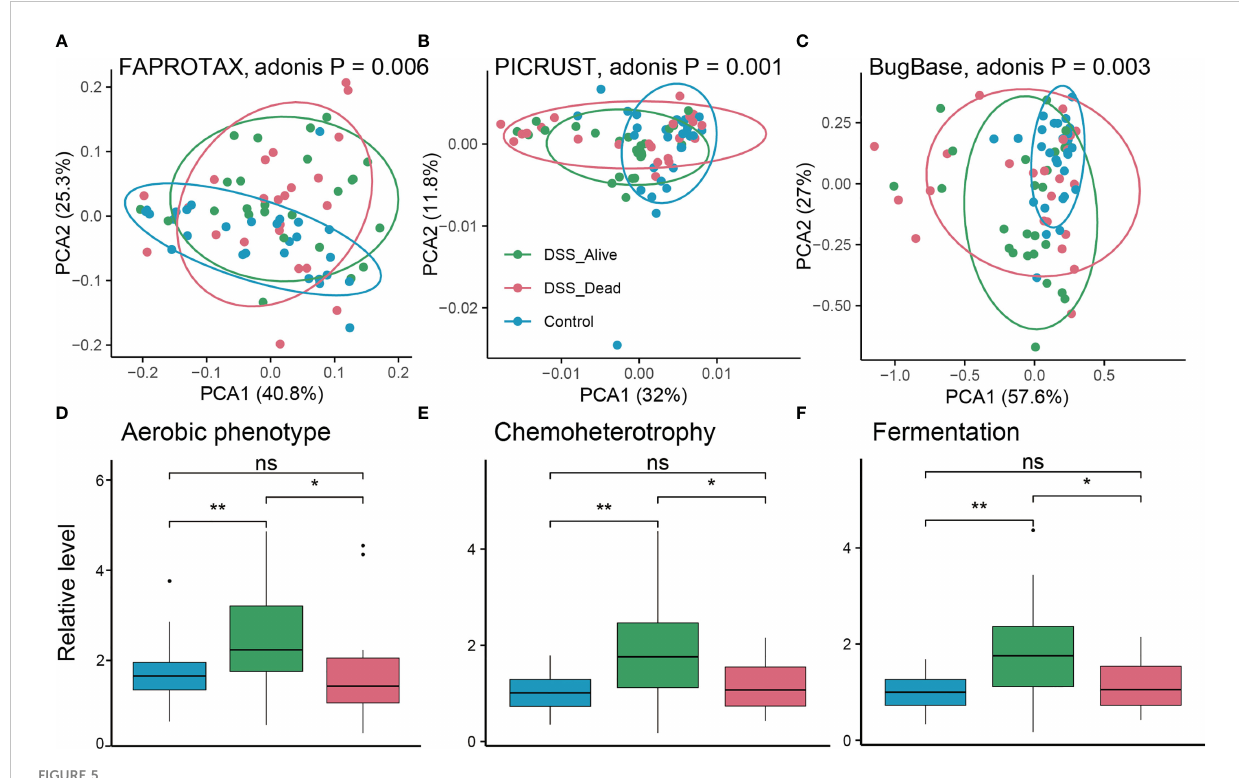
FIGURE 5 Predicted functions of the three group. PCA plot of predicted functions based on FARPROTAX (A) , PICRUST (B) , and BugBase (C) . P-values were calculated using permutational multivariate analysis of variance (Adonis). Boxplot plot of corresponding signi fi cant functions among the three group (D – F) . Wilcoxon rank-sum test was used to test signi fi cance in three groups. n.s. means no signi fi cant difference, * means P < 0.05, ** means P <